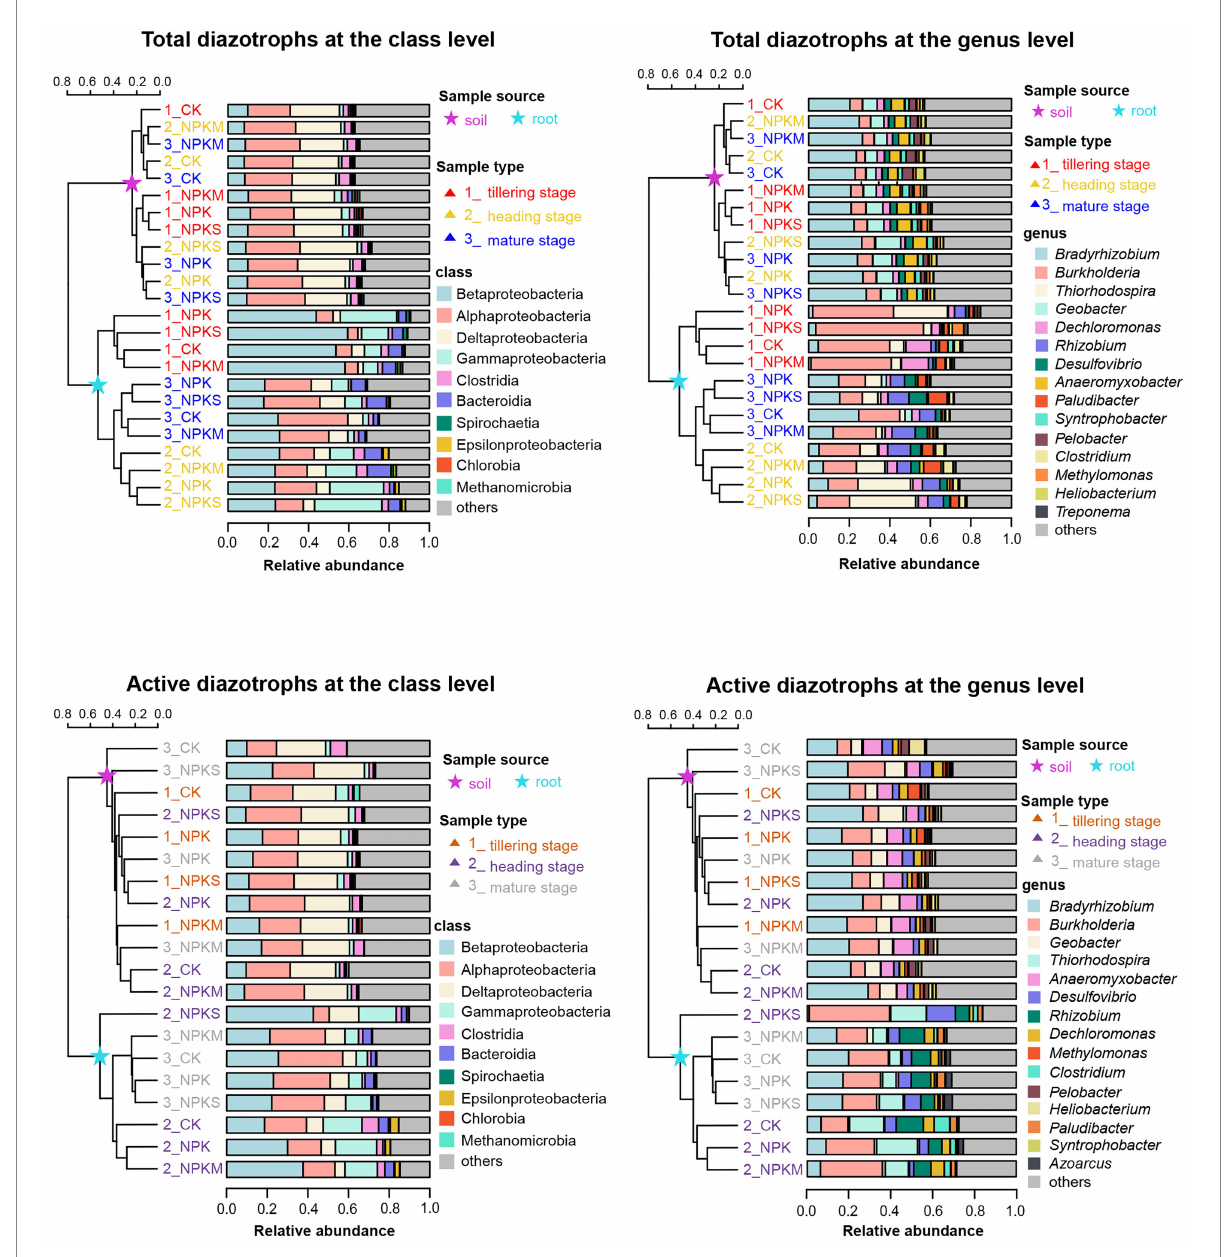
FIGURE 2 Community composition of total and active diazotrophs in rhizosphere soil and root samples at the class and genus levels in 2016. The unweighted pair group method with arithmetic mean (UPGMA) dendrogram was constructed based on Jaccard’s similarity coefficient calculated from the OTU